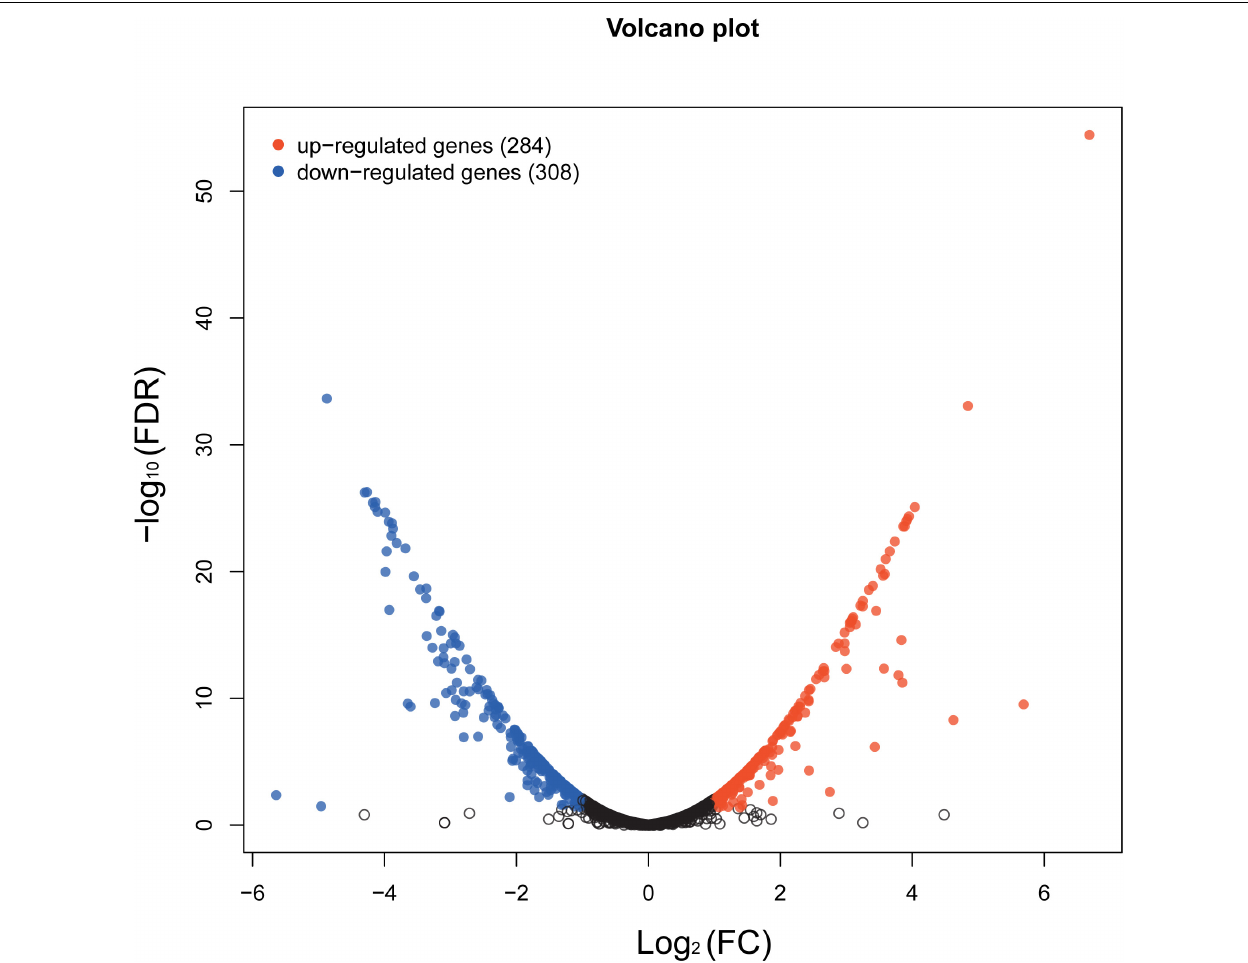
FIGURE 7 | Volcano map showing the overall scatter of differentially expressed genes (DEGs) in Staphylococcus epidermidis with or without aloe-emodin treatment. The abscissa indicates the fold-change in gene expression between the two groups (treatment/control). The ordinate indicates the statistical test values for the differences in the fold-change of expression of the transcripts. Each point in the figure represents a specific gene or transcript. Red dots indicate a significantly upregulated gene, blue dots indicate a significantly downregulated gene, and black dots indicate a non-significant change in gene expression. The further the dot is located toward the outside and top of the map, the higher the significant difference in